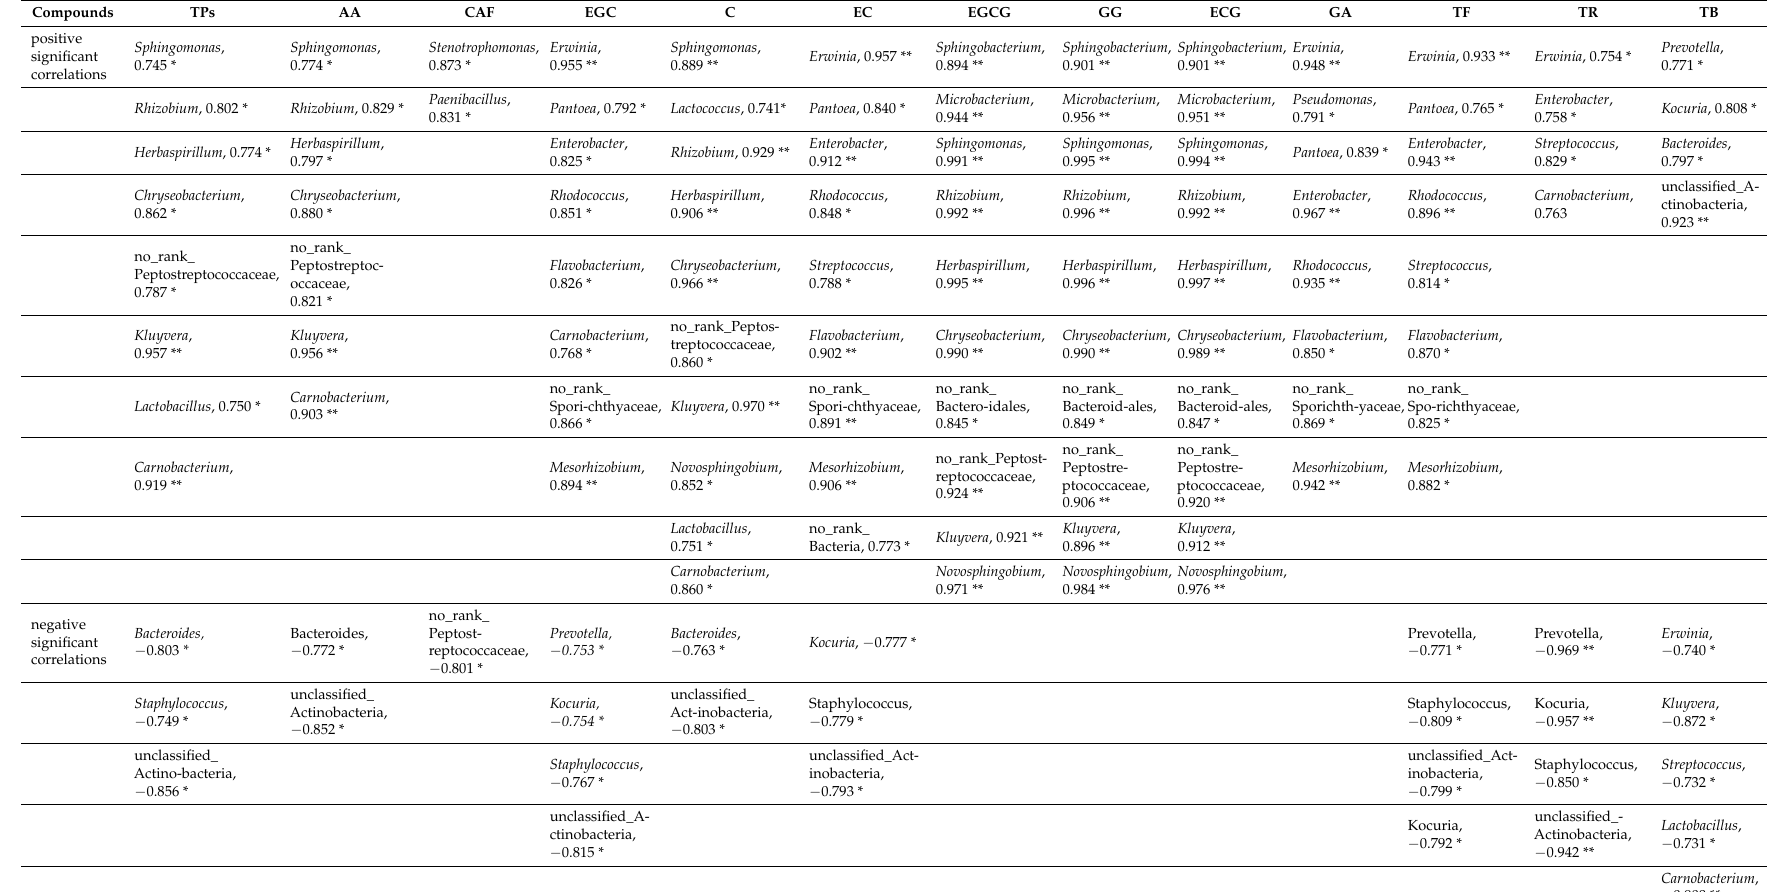
Table 3. Significant correlation coefficients between the tea’s chemical compounds and bacterial